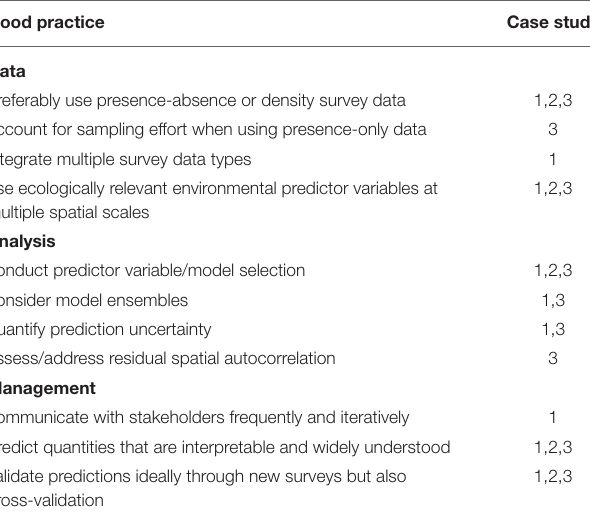
FIGURE 2 | Types of deep-sea coral and sponge species distribution models in 42 studies (journal articles, government technical reports, and book chapters) published between 2005 and 2019 ( Supplementary Material ). Common model types were maximum entropy (MaxEnt), generalized additive model (GAM), environmental niche factor analysis (ENFA), boosted regression tree (BRT), random forest (RF), and generalized linear (mixed) model (GL(M)M). Note that some studies employed more than one model type, so the total number of models is greater than the number of studies.